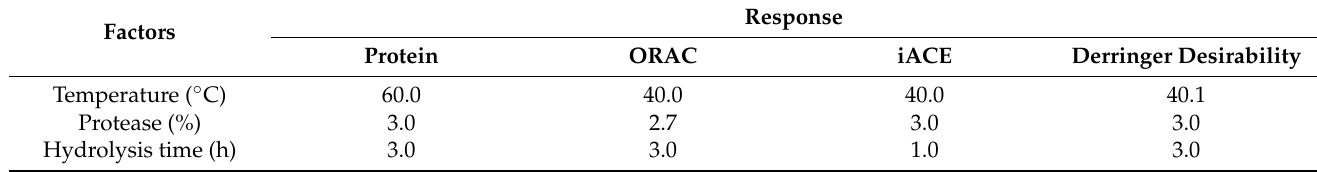
Table 11. Optimal conditions predicted by the experimental design to maximise protein/peptide release and antioxidant and anti-hypertensive activities of the hydrolysates, and Derringer desirability to predict the optimal conditions for a multiple